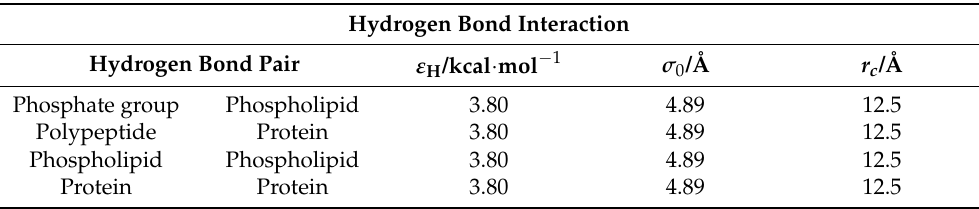
Table 1. Potential parameters of the hydrogen bond interaction. The strengths of all hydrogen bonds are set to be identical, and the strength of the hydrogen bond is a variable in our study.